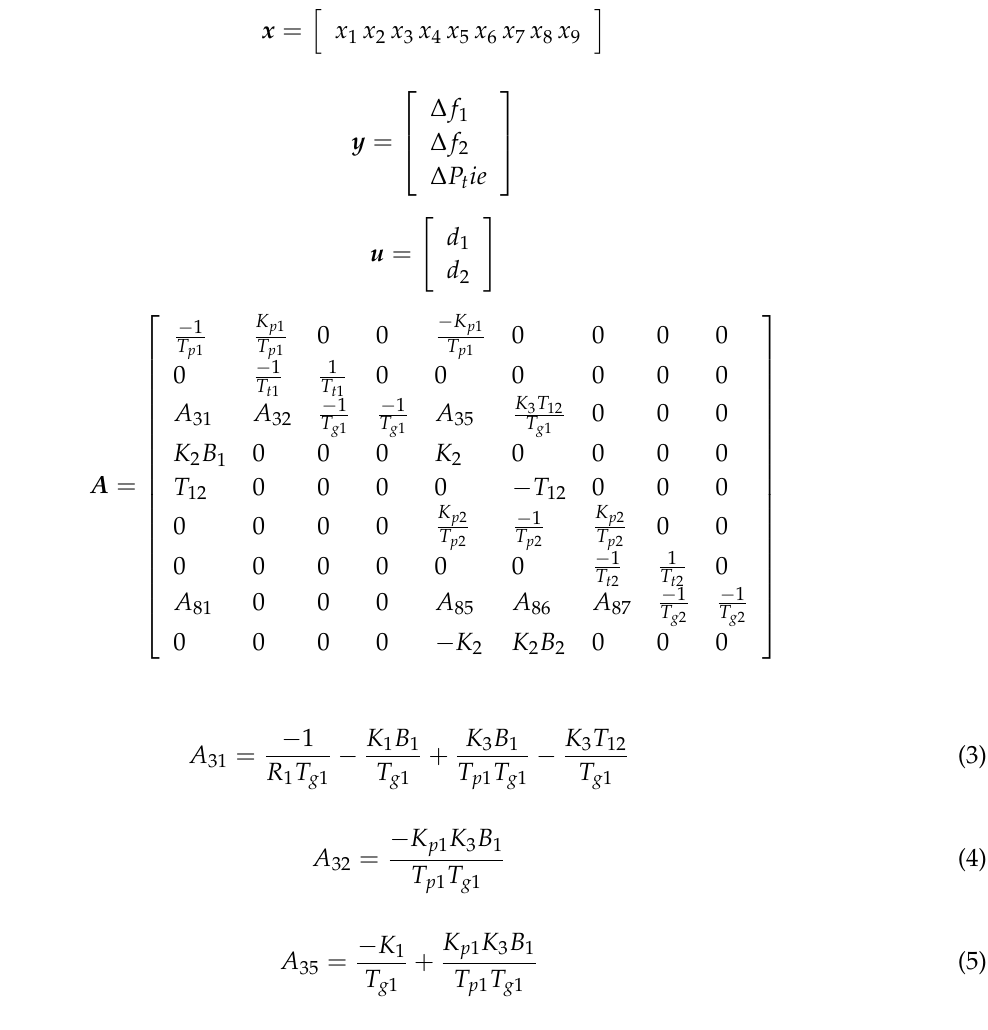
Figure 2. System under study for optimized PID